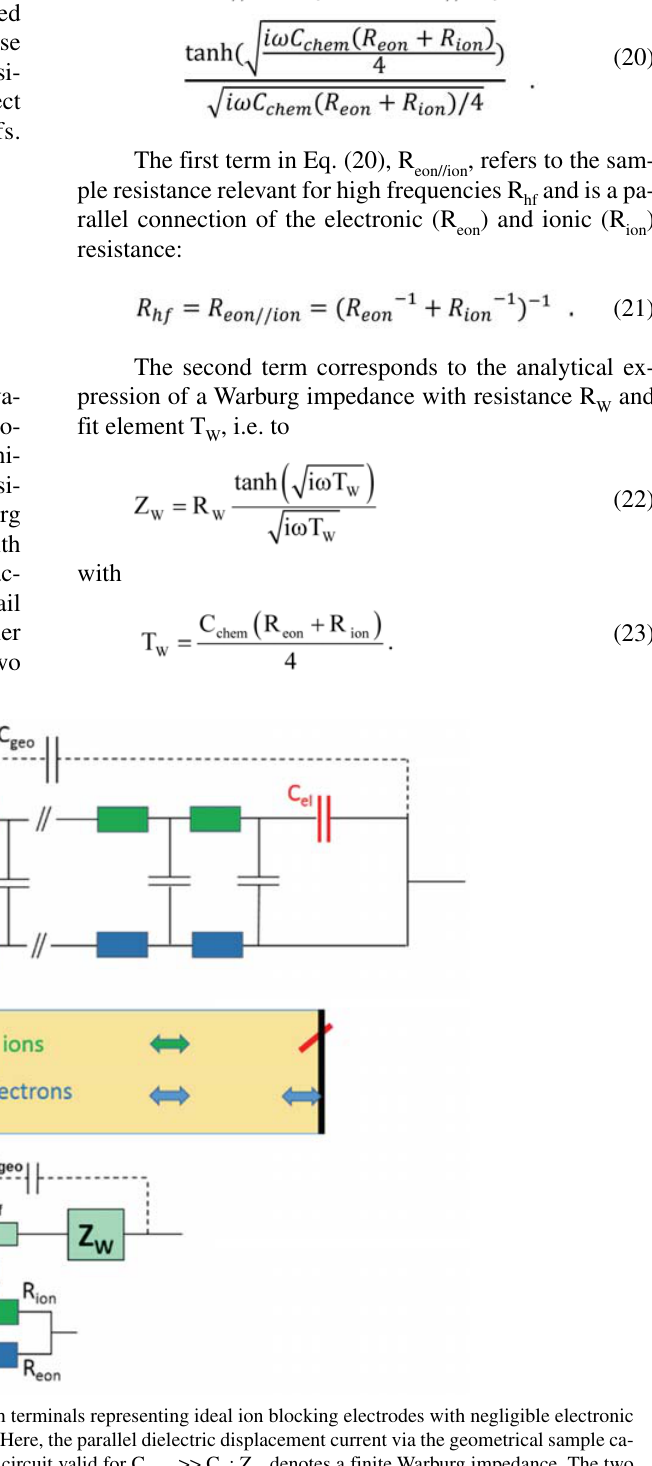
>> C ; Z denotes a finite Warburg impedance. The two chem el W